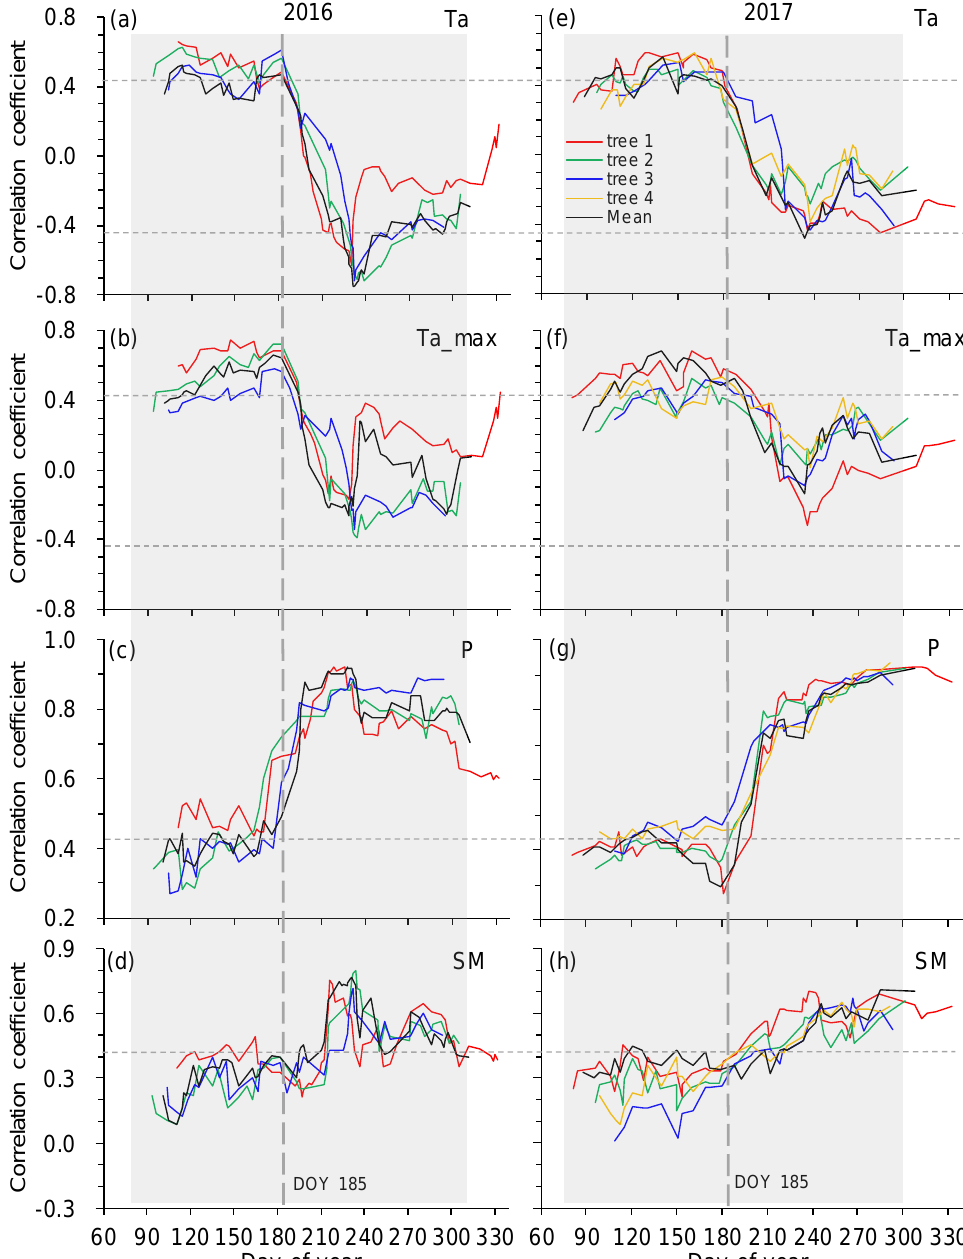
Figure 7. Moving correlations (21 days window) between stem increments and environmental variables of mean air temperature ( a , e ), maximum air temperature ( b , f ), precipitation ( c , g ), and soil moisture ( d , h ) during the growing seasons in 2016 and 2017. Spearman correlations were calculated for relationships between stem increments and all environmental variables. Horizontal thin dashed lines indicate the significance level at p = 0.05. Vertical thick dashed lines indicate the timing of shifts in the correlations between stem increments and environmental variables. The shaded regions indicate the growing seasons.